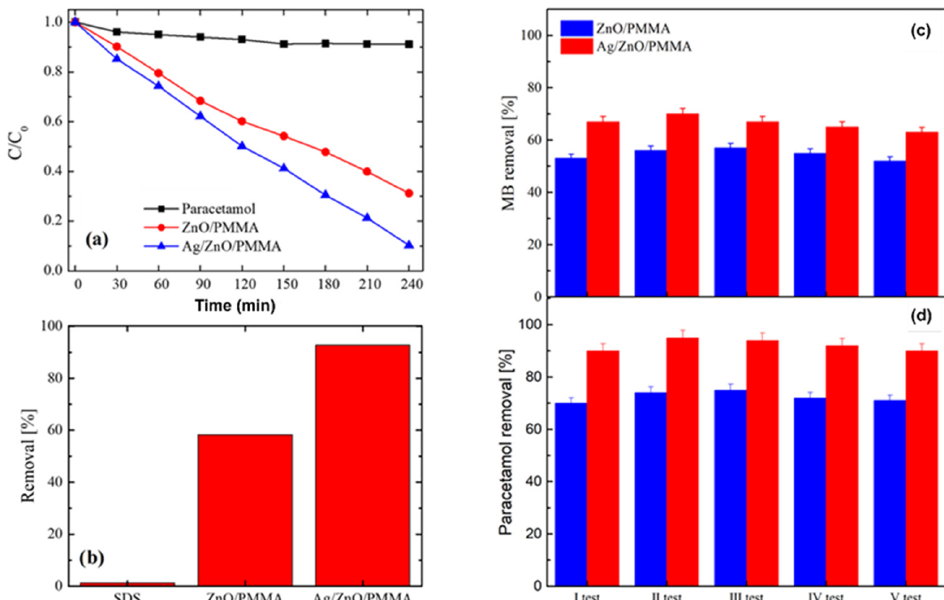
Figure 3. ( a ) Degradation of paracetamol (squares), paracetamol with ZnO/PMMA (circles) and paracetamol with Ag/ZnO/PMMA (triangles) as a function of irradiation time. ( b ) Degradation after 4 h UV radiation exposure for SDS, SDS with ZnO/PMMA and SDS with Ag/ZnO/PMMA. ( c , d ) Recyclability of ZnO/PMMA and Ag/ZnO/PMMA after five tests of MB (top) and paracetamol (bottom) photodegradation. Adapted from Ref. [62].